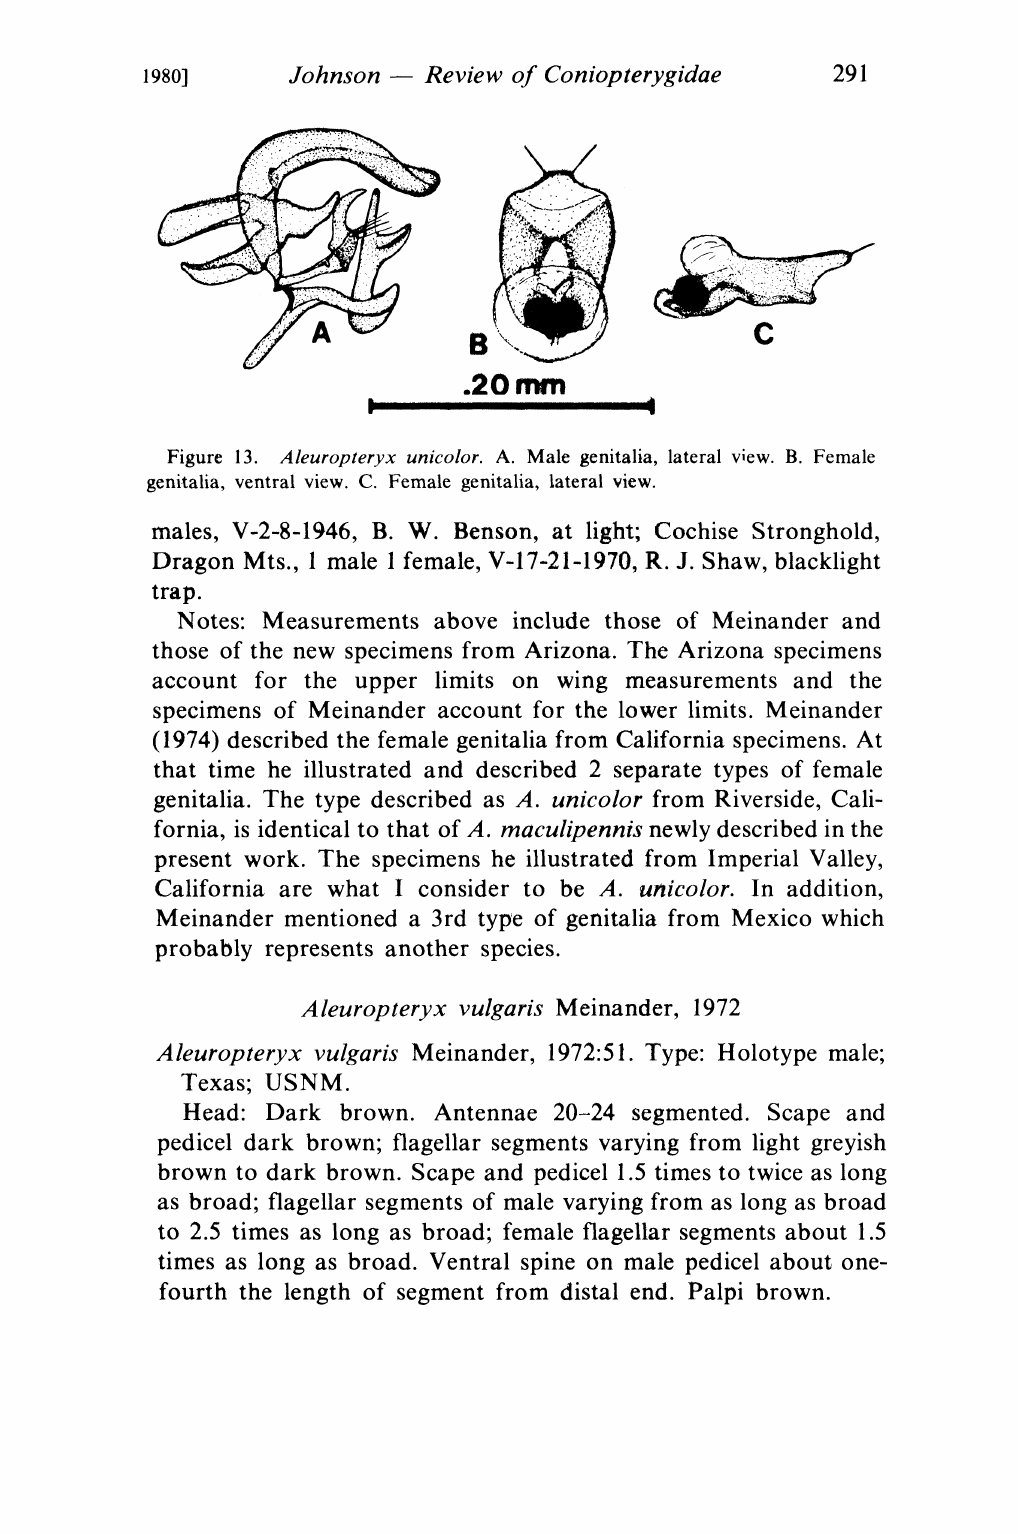
Figure 13. Aleuropteryx unicolor. A. Male genitalia, lateral view. B. Female genitalia, ventral view. C. Female genitalia, lateral